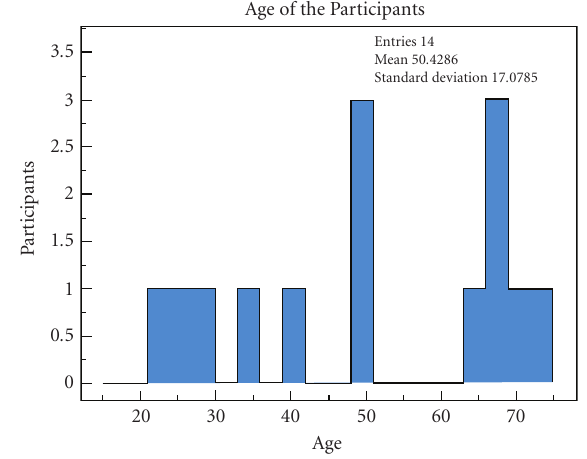
Figure 2: Distribution of the age of the subjects.